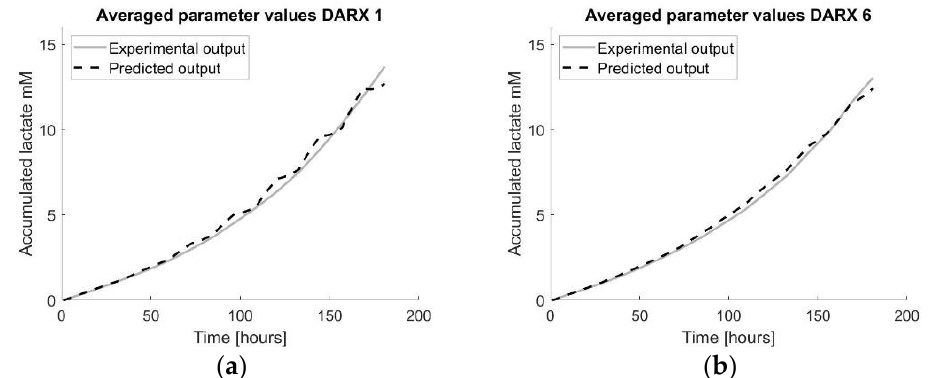
Figure 8. Visualisation of the prediction models using multiple datasets by applying a transfer function model for all datasets and averaging the model parameters a and b into one average transfer function model. The number in the title refers to the number of the tissue flask used as the test set. ( a ) visualizes the prediction model developed using the average parameter values obtained by applying DARX transfer function models on each training set using TF1 as the test set. ( b ) visualizes the prediction model developed using the average parameter values obtained by applying DARX transfer function models on each training set using TF6 as the test set. Table 10. NRMSE comparing the accumulated lactate output values of the forecast model using multiple datasets by applying DARX transfer function models on the different datasets and averaging the parameters using the goodnessOfFit function in MATLAB. The NRMSE closer to zero represents the better fit. The number of the tissue flasks referrers to the tissue flask used as the test data set. TF1 TF2 TF3 TF4